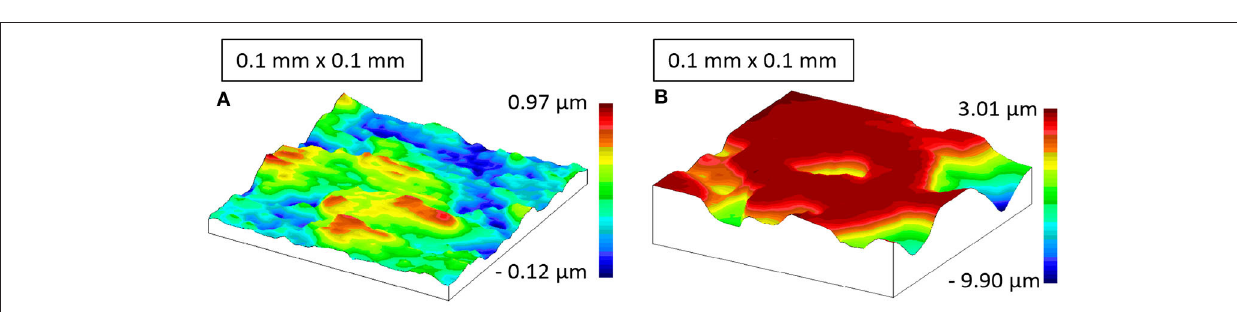
FIGURE 11 | Surface of tribochemical wear (A) Sdq = 0.083; Sdr = 0.258%; (B) Sdq = 0.388; Sdr =